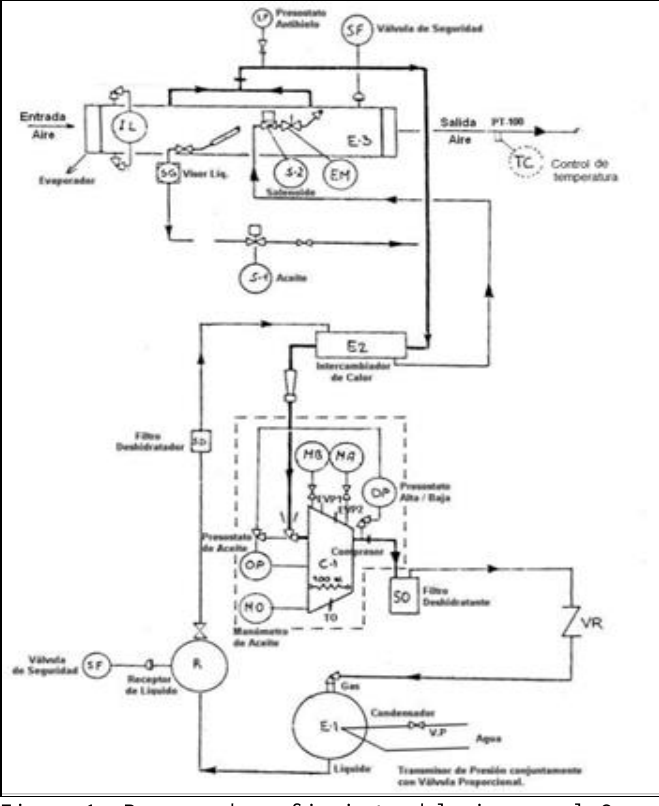
Figura 1: Proceso de enfriamiento del aire en el Grupo